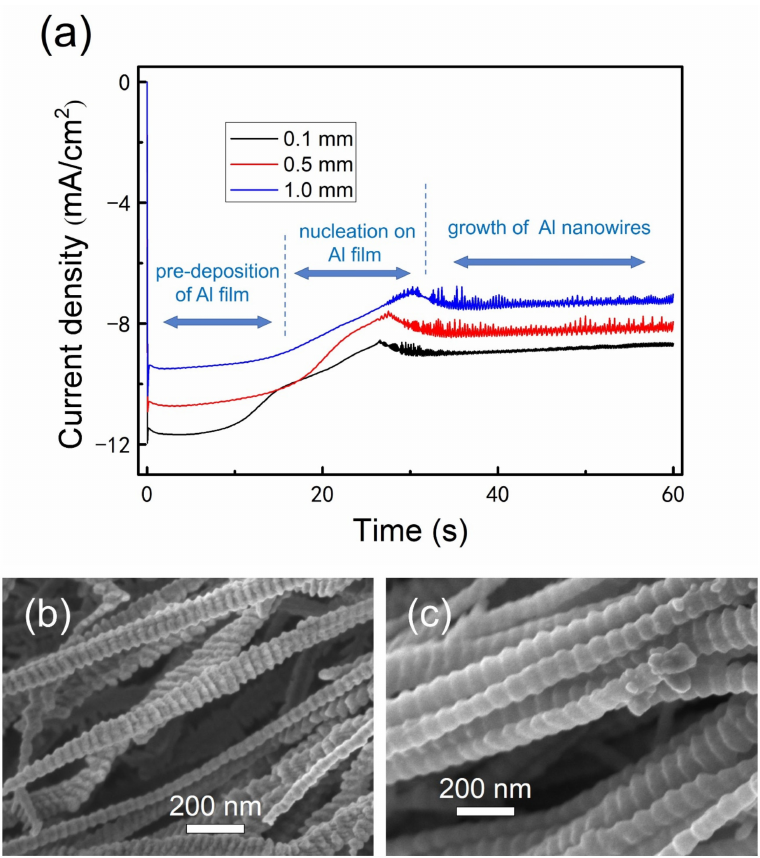
Figure 6. Potentiostatic electrodeposition of Al nanowires at − 1.2 V/25 ◦ C for 60 s under the restricted diffusion condition (inner diameter of the insulation ring was 8 mm). ( a ) Chronoamperometry curves recorded on Cu plate with different thicknesses of insulation ring. SEM images of the electrodeposited Al nanowires on the central part of Cu plate, using an insulation ring with a thickness of ( b ) 0.1 mm and ( c ) 0.5